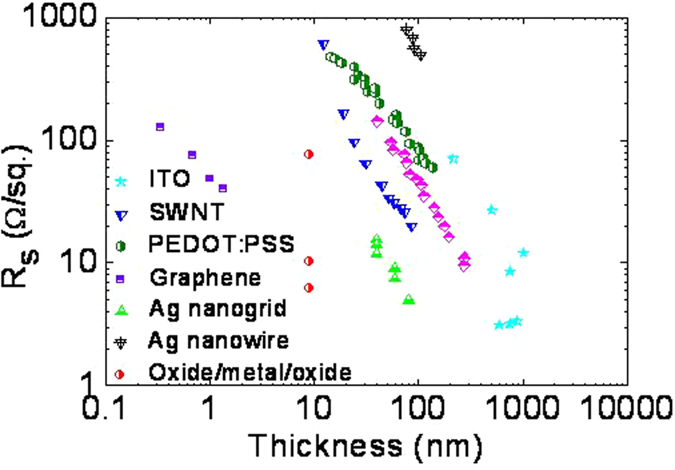
Sheet resistance (Rs) as a function of film thickness for different TCE films: Ag, Al and Cu metal grids30; PEDOT:PSS31; ITO films3233; SWNTs32; Ag nanogrid32; oxide/Ag/oxide films34; and graphene32.